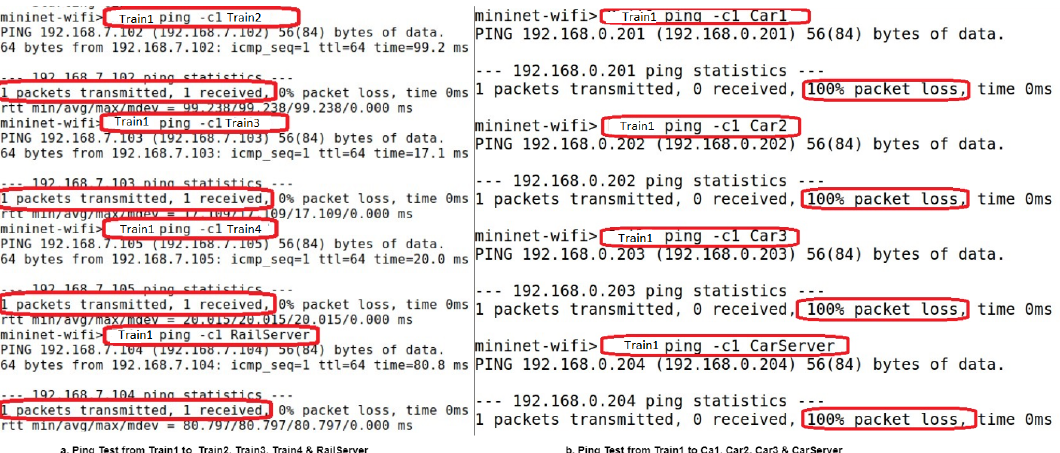
Figure 18. Reachability test for cars.